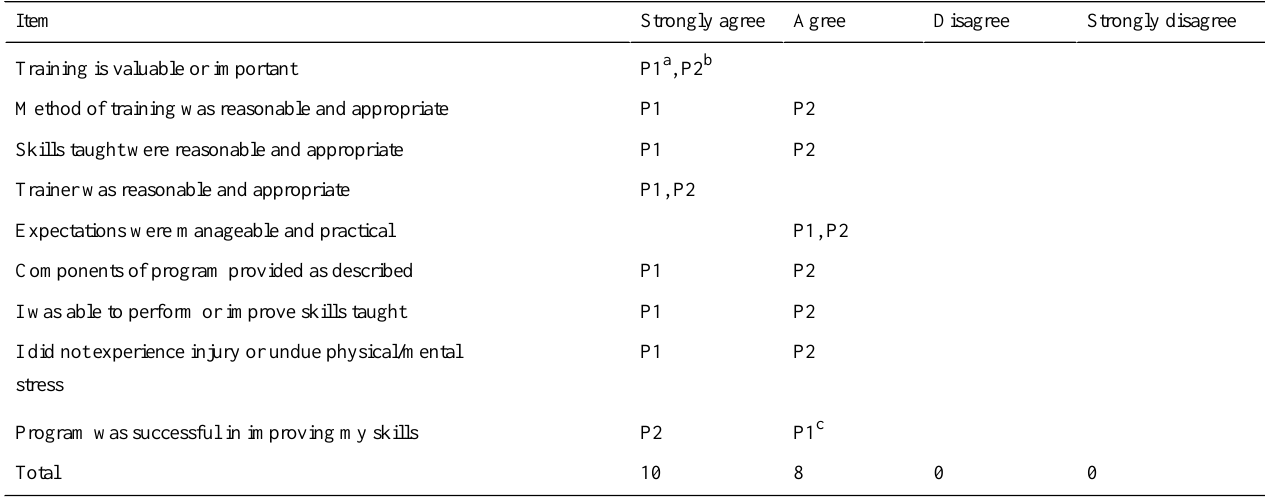
Table 2. Post-treatment questionnaire responses by participant 1 and 2.